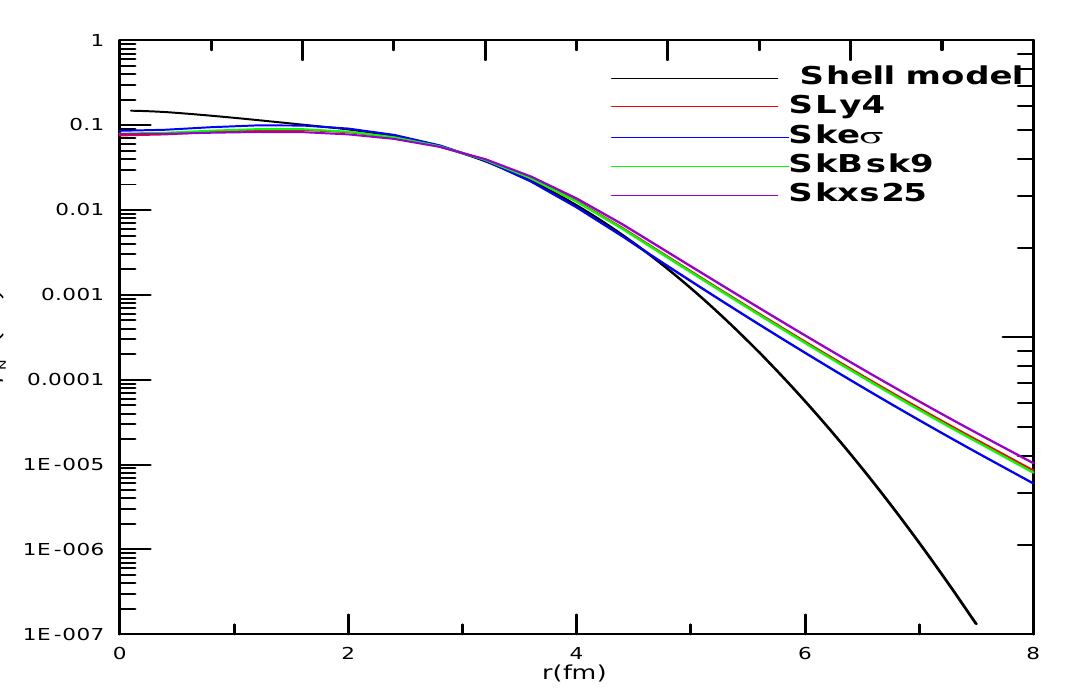
Fig.5: Neutron density distributions of 21 F.